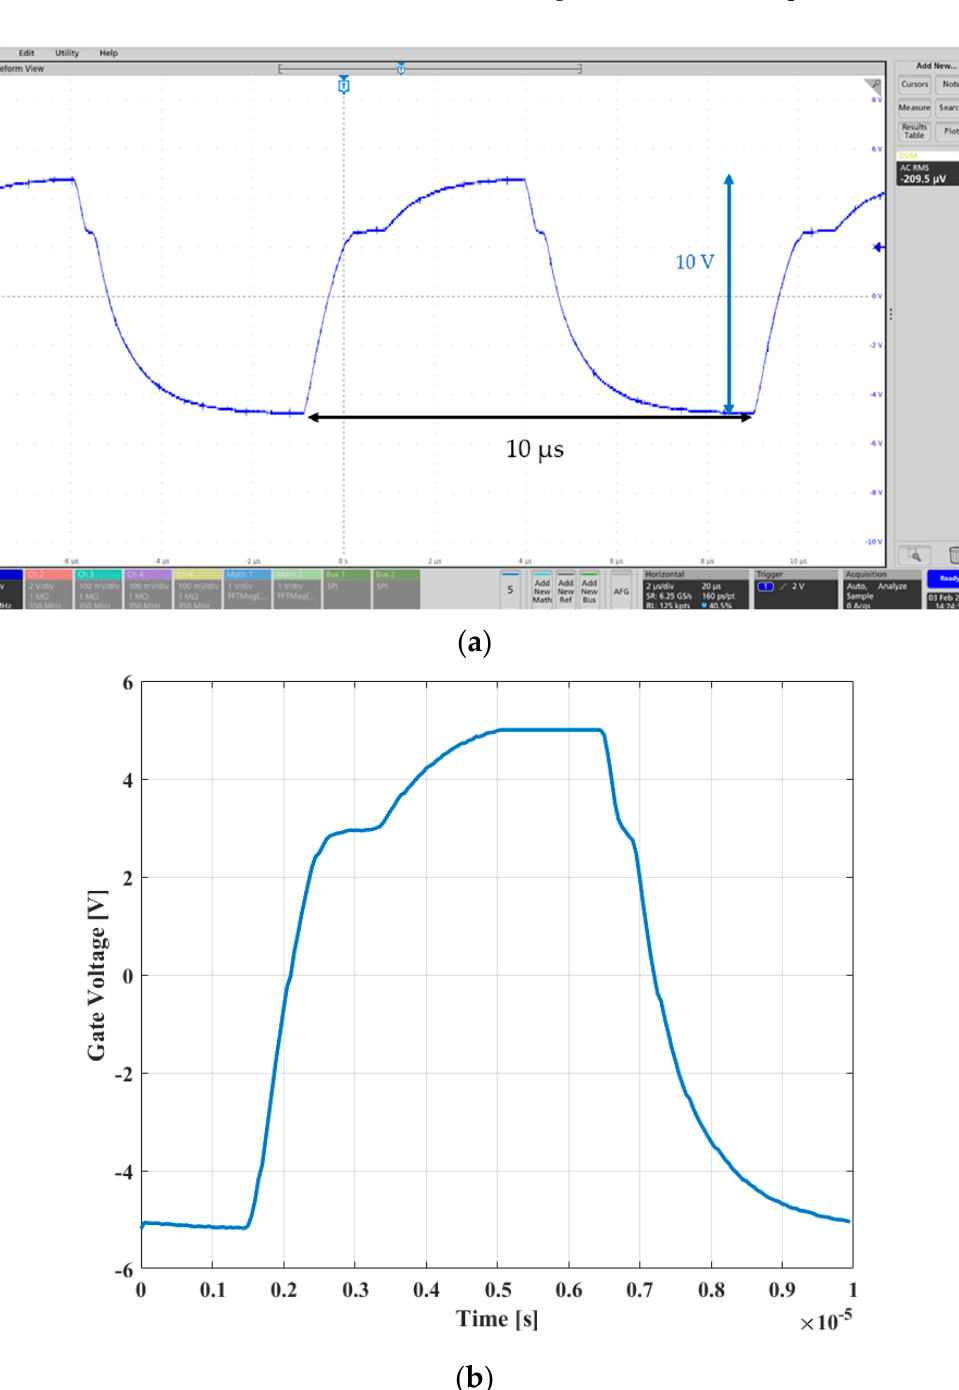
Figure 10. Switching gate voltage at 100 kHz. ( a ) Oscilloscope measurement. ( b ) Waveform obtained by the embedded measurement system.